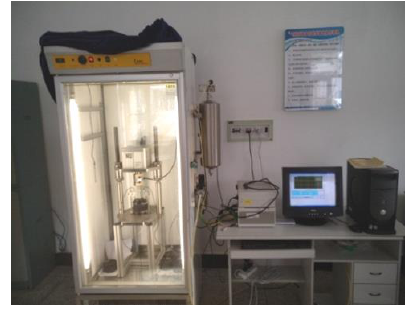
Figure 5. NU-14 pneumatic servo asphalt mixture testing machine.